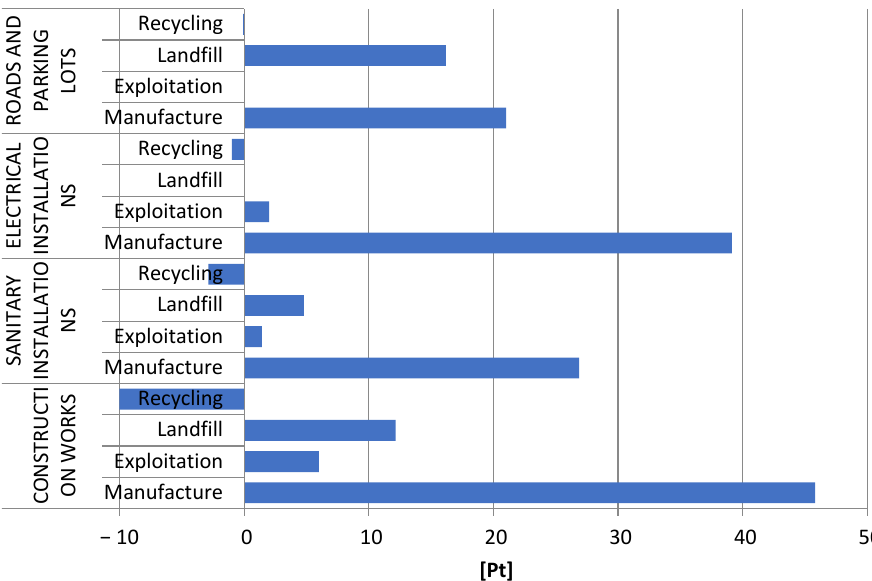
Figure 15. The results of grouping and weighing the environmental consequences occurring at individual stages of the life cycle of the research object by groups of